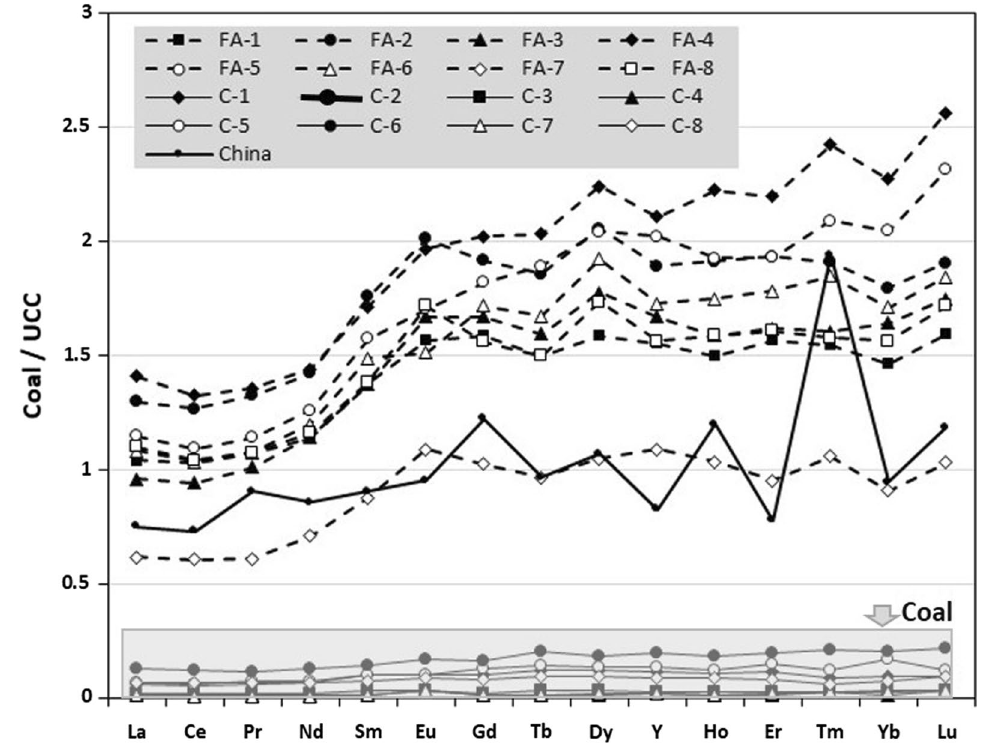
Fig. 10 Graphic comparison of individual REY contents in coal (C1-C8) and FA (FA1-FA8) samples (normalized to